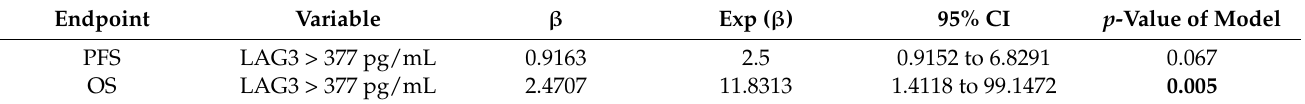
Table 4. MVA of PFS and OS.